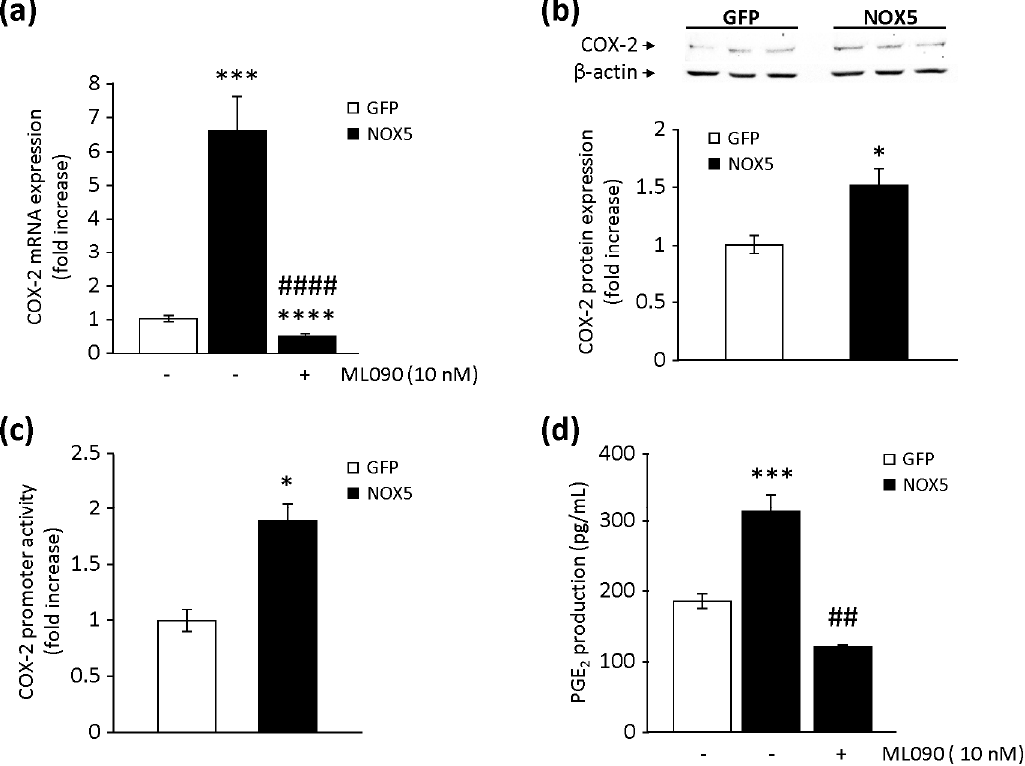
Figure 2. Effects of NOX5- β overexpression on prostaglandin (PG) biosynthesis in TeloHAEC. ( a ) COX-2 mRNA levels in NOX5- β - and GFP-infected cells for 12 h, in the presence or absence of ML090. n = 6. *** p < 0.001 vs. GFP, **** p < 0.0001 vs. GFP, and #### p < 0.0001 vs. NOX5. ( b ) Representative COX-2 and β -actin immunoblots from cells infected for 12 h, and quantification of the COX-2 protein. n = 5. * p < 0.05 vs. GFP. ( c ) COX-2 promoter transcriptional activity of cells infected for 24 h. n = 6. * p < 0.05 vs. GFP. ( d ) PGE 2 levels present in cell supernatant after 12 h of infection in the presence or absence of ML090. n = 6. *** p < 0.001 vs. GFP, and ## p < 0.01 vs. NOX5.